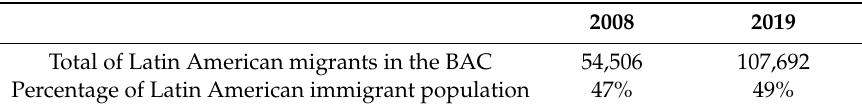
Table 5. Latin American immigration (percentage).